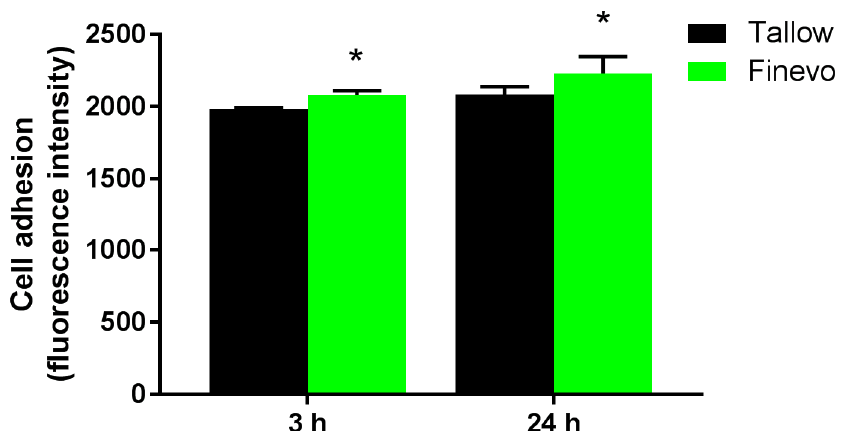
Figure 6. Adhesion of rat bone marrow mesenchymal stem cells on different samples after 3 and 24 h. The level of cell adhesion on Finevo-Ti after in 3 h was significantly higher than that on Tallow-Ti. This trend was also observed at 24 h. Black: Tallow-Ti, Green: Finevo-Ti, Red: Plasma-Ti, Blue: UV-Ti. (* p <0.05)